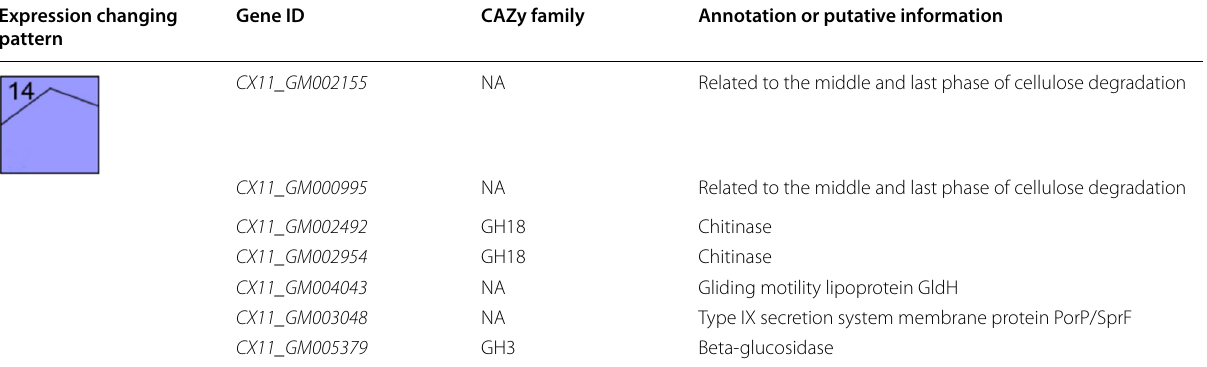
difference(See figure on next Fig. 5 Comparison of RT-qPCR results with RNA-seq results. A and B are the top 2 DEGs in “0” pattern. C and D are the top 2 DEGs in “4” pattern. E and F are the top 2 DEGs in “11” pattern. G and H are the top 2 DEGs in “14” pattern. **means p < 0.01, highly significant difference, and no *means no significant